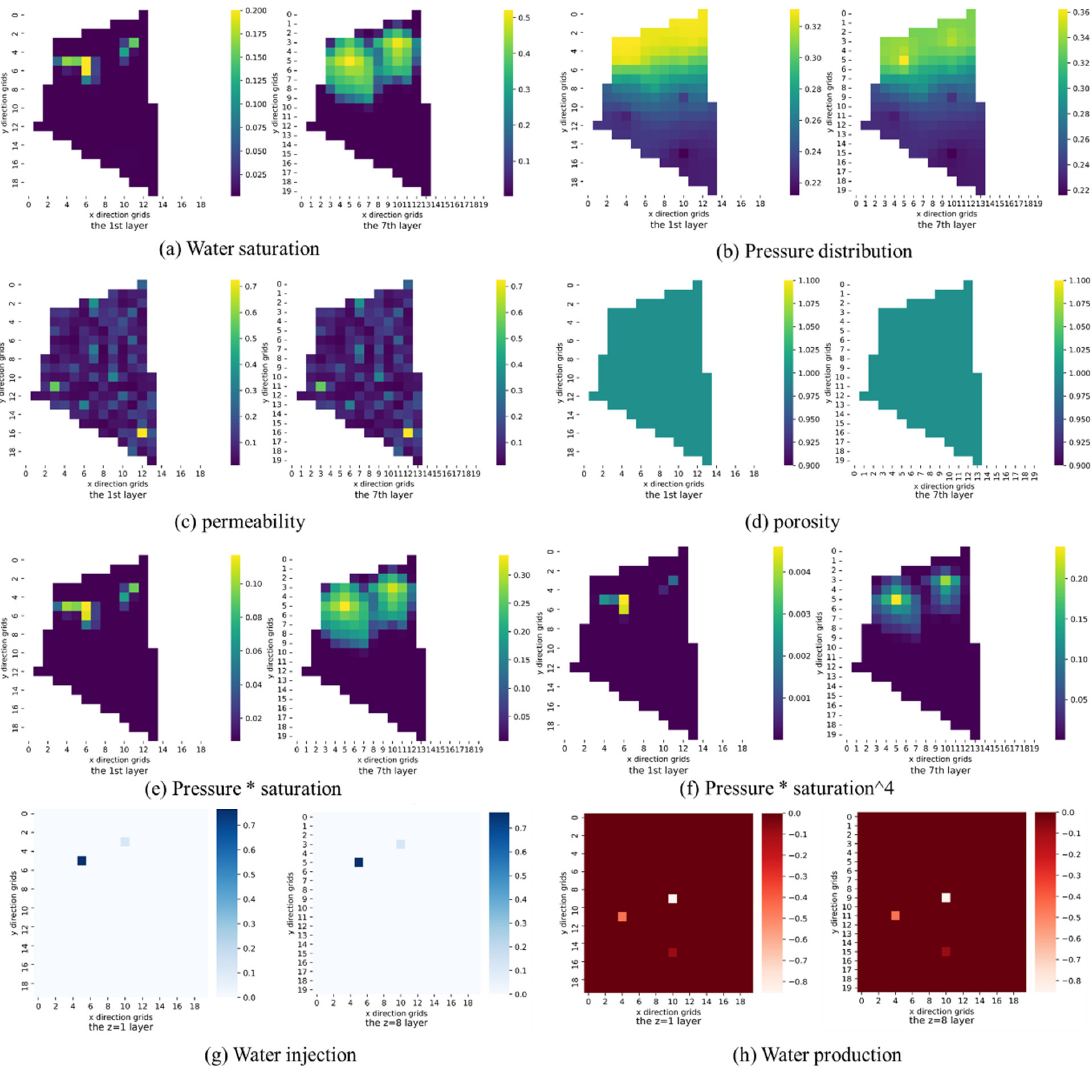
Figure 8. The amplification results of features.